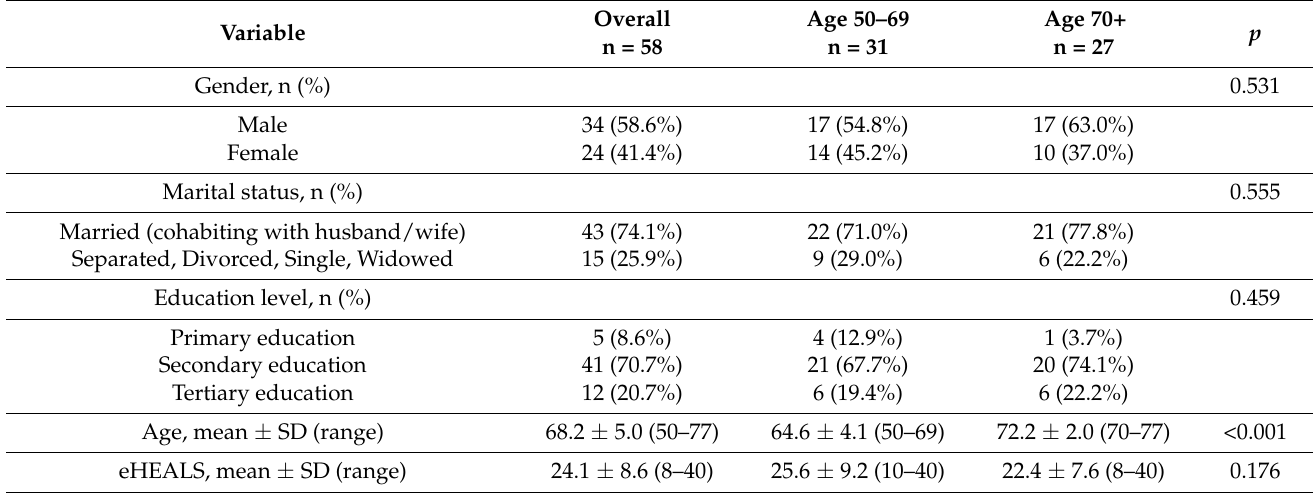
Table 2. Demographic, social, and eHealth literacy characteristics of the